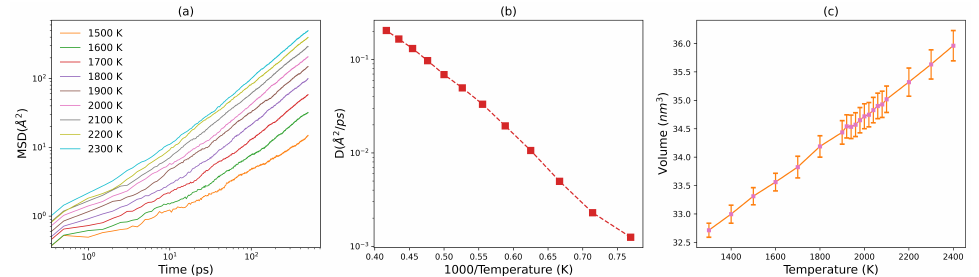
Figure 3. ( a ) Average mean square displacement of all atoms of anorthite system (CaO · Al 2 O 3 · 2SiO 2 [50]) versus time at different temperatures. ( b ) Simulated diffusion coefficient as a function of 1000 . ( c ) Simulated system volume as a function of temperature under 1 atm pressure (error bars are T standard